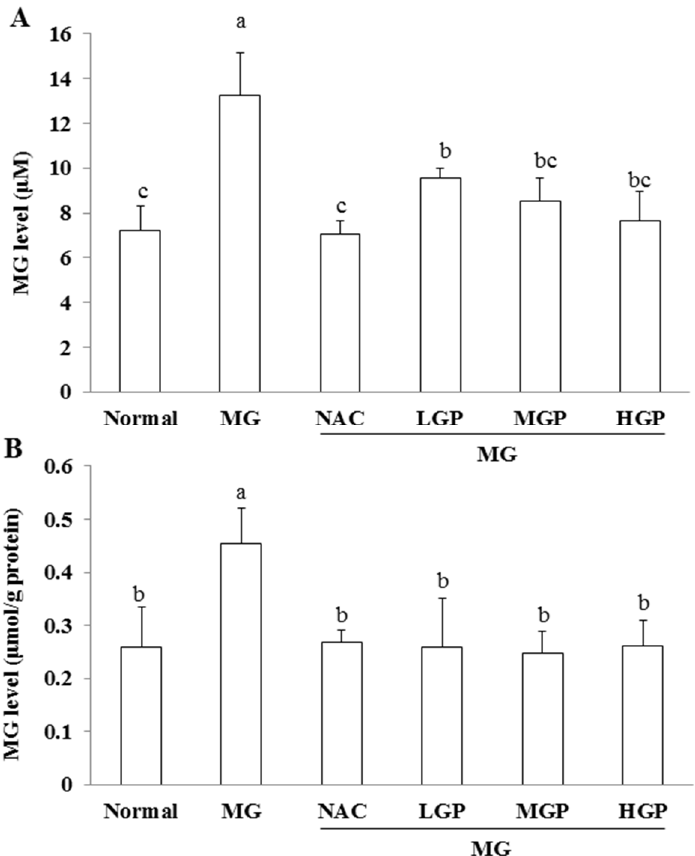
Figure 3. Effects of WGP on methylglyoxal levels: ( A ) the results from the serum samples and ( B ) the results from the livers of MG-treated rats. Each value is expressed as the mean ± SD ( n = 6). a–c Values in a column with di ff erent superscripts are signi fi cantly di ff erent ( p < 0.05).